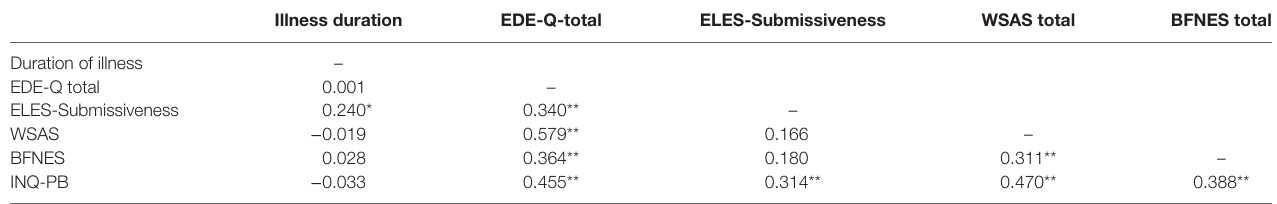
TaBle 2 | Correlations between duration of illness, work and social adjustment (WSAS), eating disorder symptoms (EDE-Q total score), early memories of submissiveness (ELES-Submissiveness), fear of negative evaluation (BFNES) and perceived burdensomeness